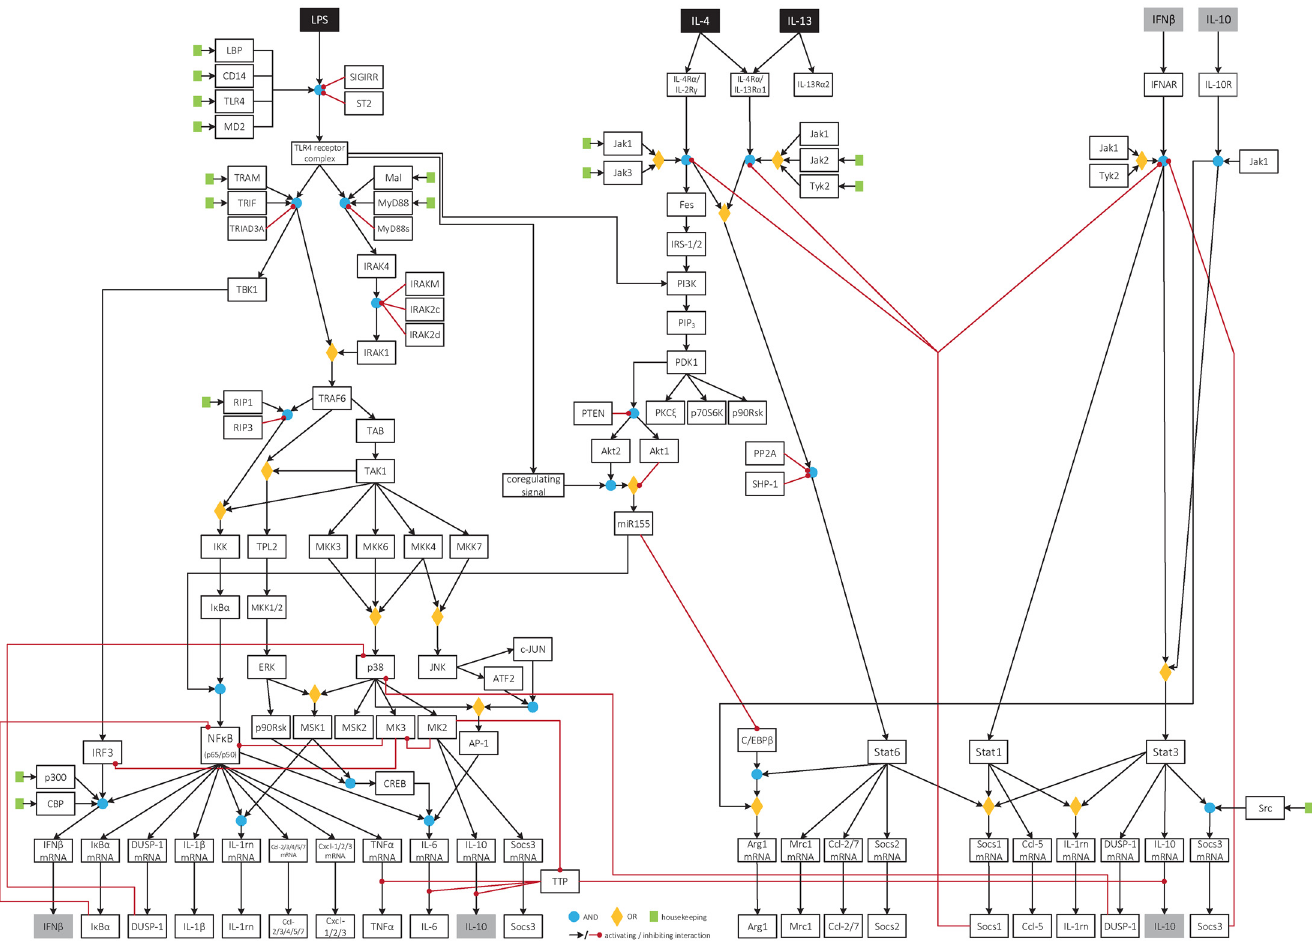
Fig 11. Refined version of the Boolean model of M1 and M2 macrophage activation. This model describing macrophage activation into the M1 and M2 phenotype is specifically adapted to measurement data from our experimental system of primary murine BMDMs. Inputs of the system are LPS, IL-4 and IL-13 depicted in black. The model is displayed as logical interaction hypergraph containing 132 nodes and 152 interactions. Black arrows and red lines denote activating and inhibiting interactions, respectively. Logical AND connections are expressed using blue dots, and OR connections by yellow diamonds. The housekeeping node is depicted by green rectangles indicating all species that are already present in the unstimulated state of the cell. Grey-shaded species denote cytokines that are secreted by the cells and are able to mediate autocrine feedback.